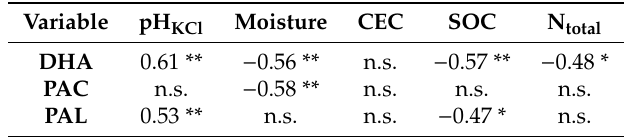
Table 3. Pearson’s linear correlation results for independent variables. Variable pH KCl Moisture CEC